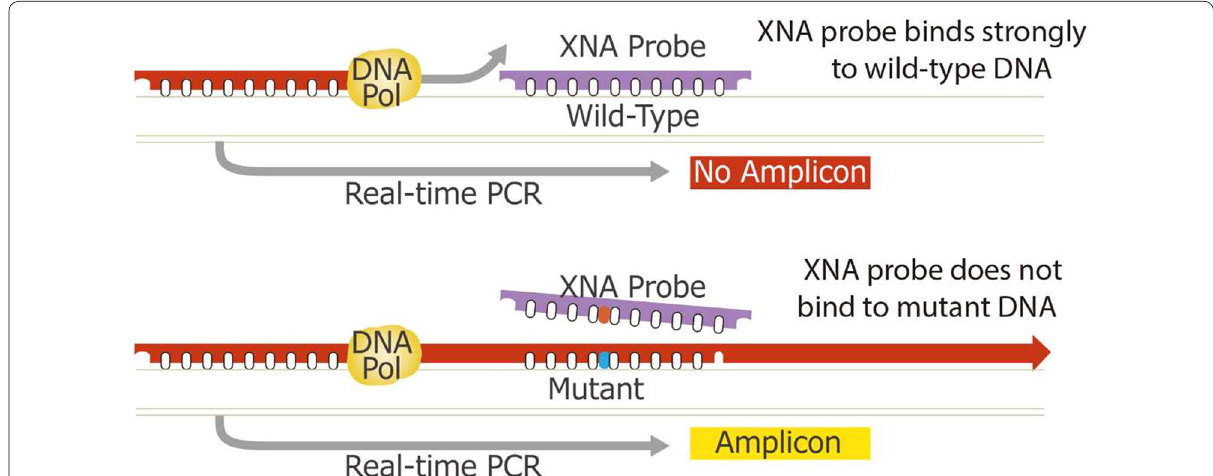
Fig. 4 QClamp ™ xenonucleic acid (XNA) probe hybridizes to wild-type DNA (WT-DNA) templates and prevents WT-DNA from being amplified, while melting off from the mutant DNA template so that only mutant DNA is